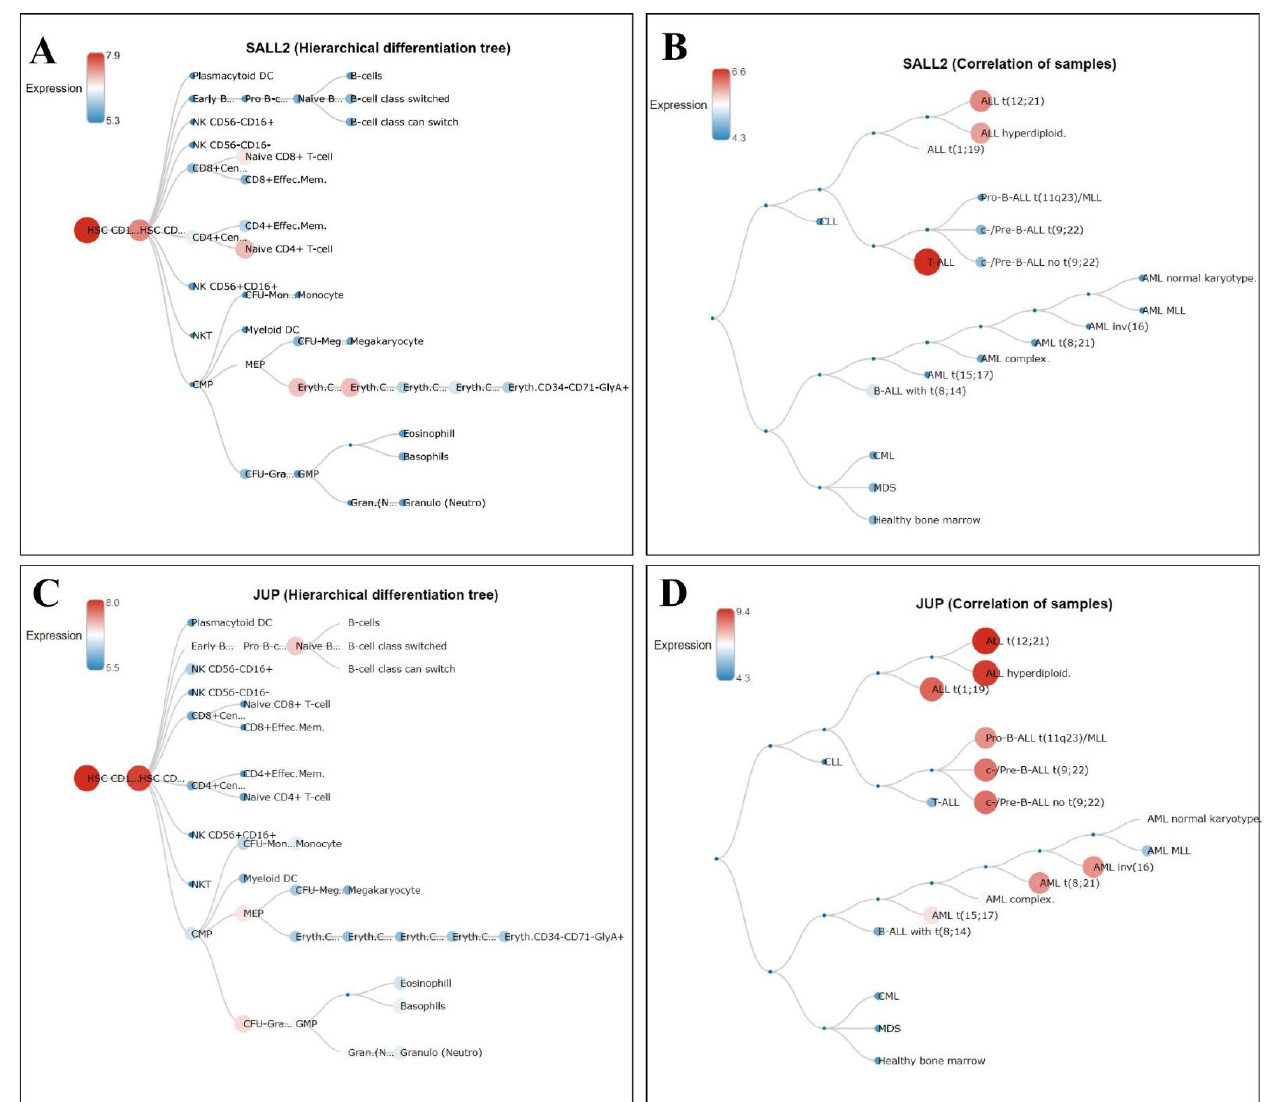
Figure 7. Hierarchical trees of SALL2 and JUP using BloodSpot. Expressions of SALL2 ( A ) and JUP ( C ) during the hematopoietic process. The expression scale is indicated in each graph from red (higher expression) to blue (lower expression). Full names are included from left to right: HSC- CD1 — hematopoietic stem cell_CD133+CD34dim; HSC-CD — hematopoietic stem cell_CD38-